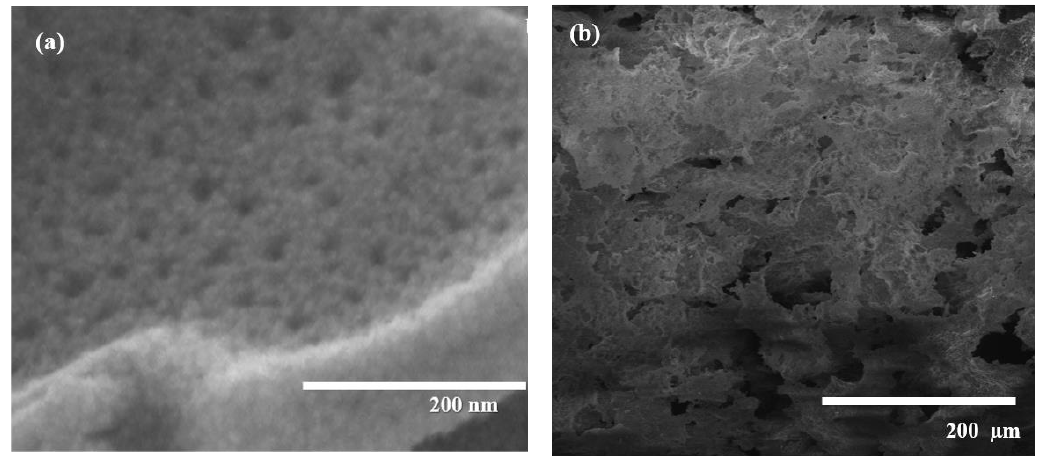
Fig. 1 SEM image of a) p(AMPS-H + - co -VIm) hydrogels, b) p(AMPS-Na + - co -VIm) hydrogels Fig. 1. SEM image of a) p(AMPS-H + - co -VIm) hydrogels, b) p(AMPS-Na + - co -VIm)